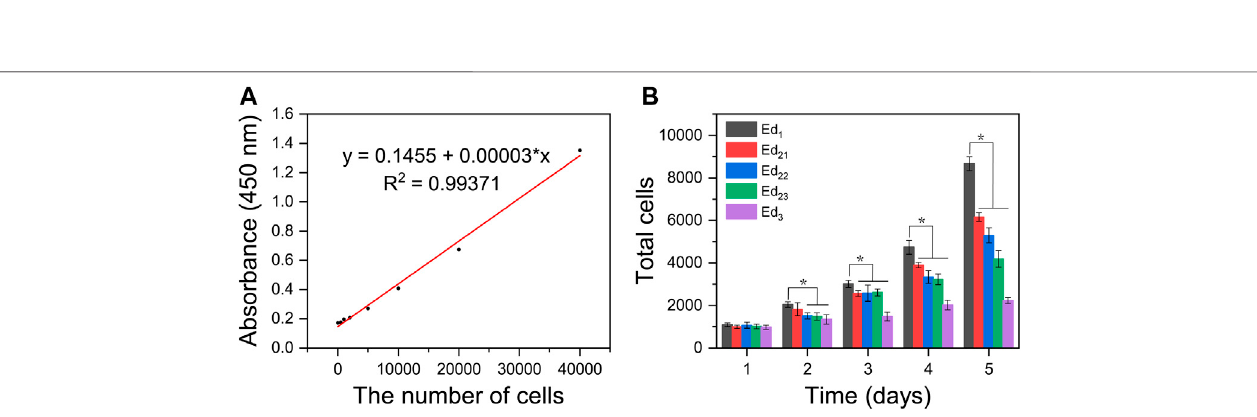
FIGURE 7 | Quantitative analysis of in vitro biological characteristics of scaffolds. (A) Absorbance value at 450 nm of different amounts of MC3T3-E1 cells. (B) Proliferation activity of the adhered MC3T3-E1 cells on different scaffolds after 1, 2, 3, 4, and 5 days of incubation, detected by the CCK8 assay. ( n = 7, error bar represents the mean ± SD, * indicates a signi fi cant difference compared with Ed 1 , p < 0.05).